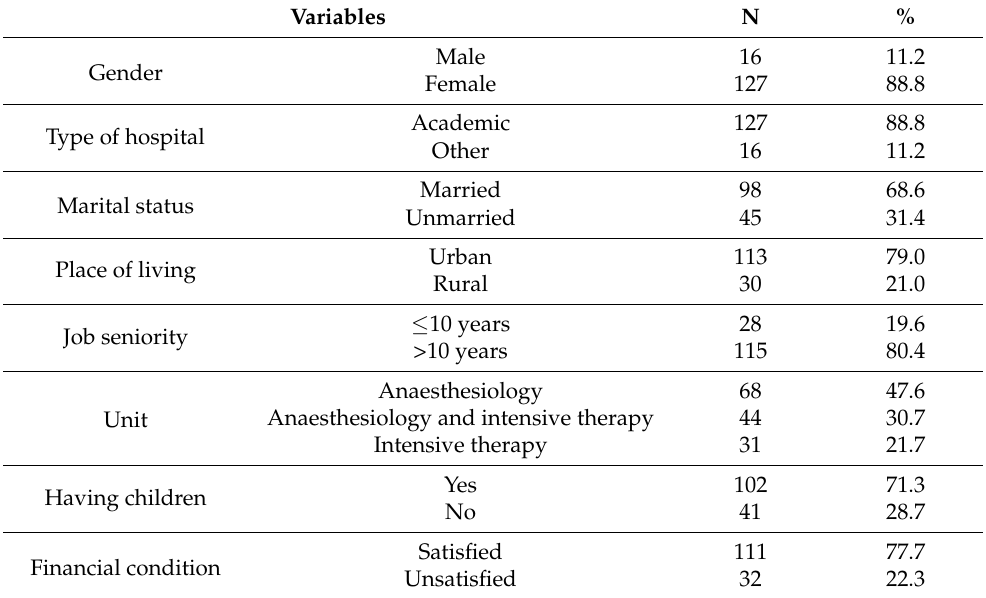
Table 1. Group characteristics ( n = 143).